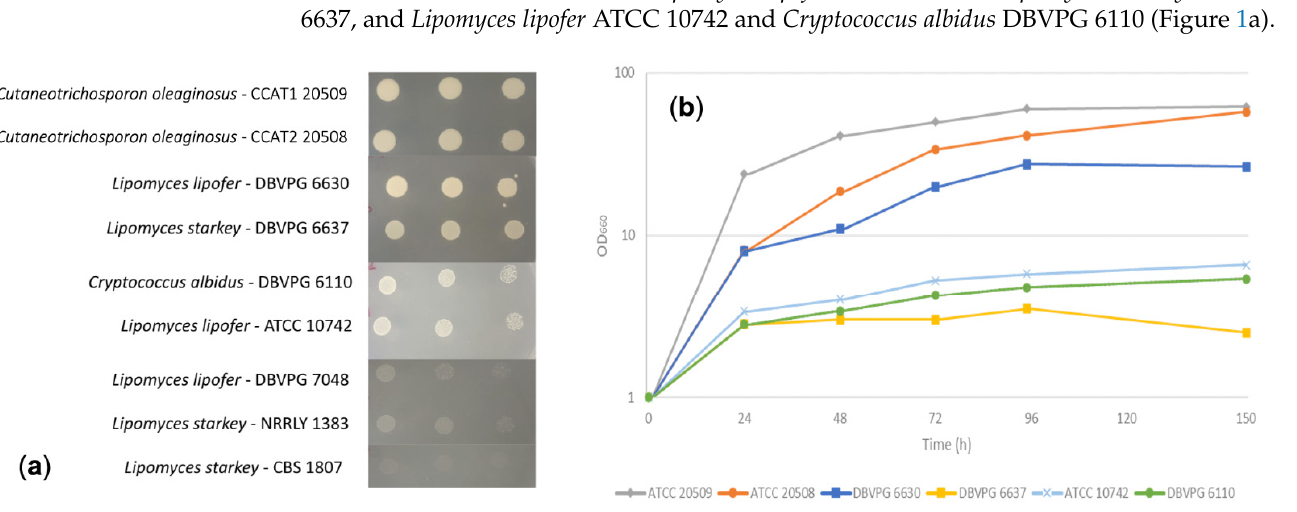
Figure 1. ( a ) Different strains spotted on YNB-lactose plate at different concentrations (10 5 , 10 4 , and 10 3 cells) and incubated for 5 days at 30 °C. ( b ) Screening on whey permeate without any addition (WP).